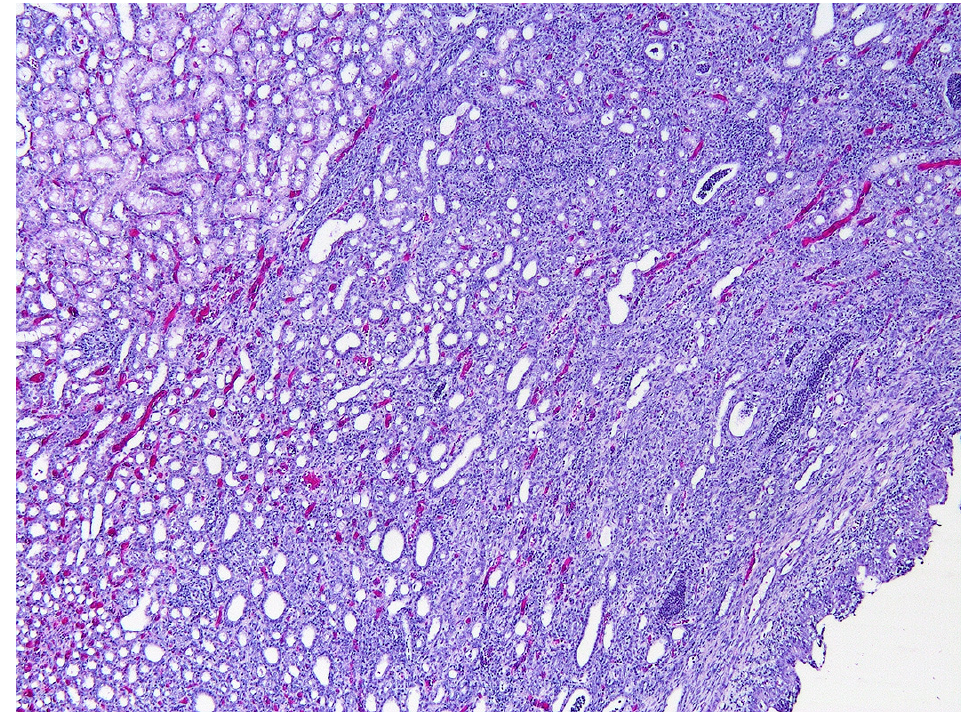
Figure 2. Photomicrograph of a kidney from the same rat as in Figure 1. The renal pelvis (lower right) is lined with thickened uroepithelium. The renal parenchyma has been infiltrated by large numbers of inflammatory cells, and inflammatory cells are visible within, and dilating, tubules. More normal renal parenchyma is visible within the top left of the figure. HE 50×.